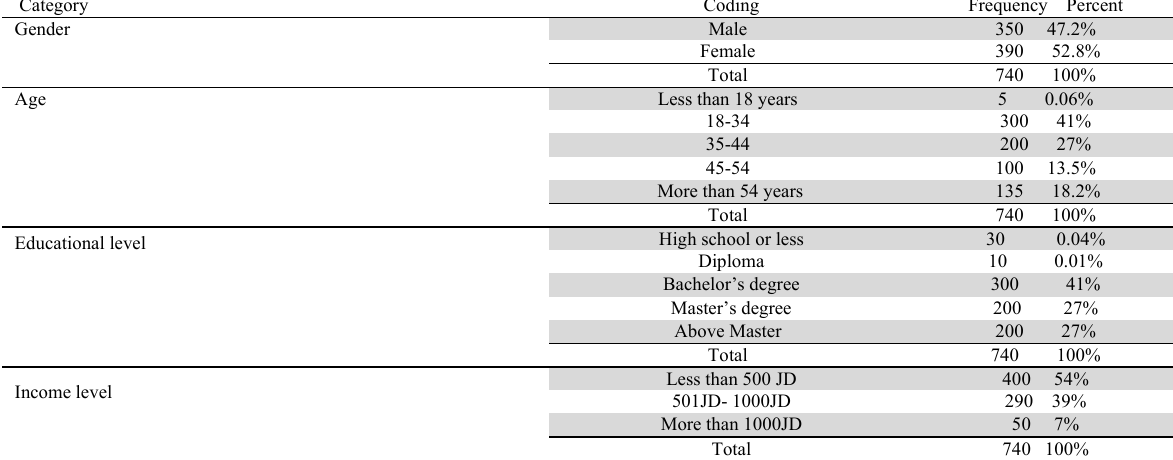
Demographic Characteristics of